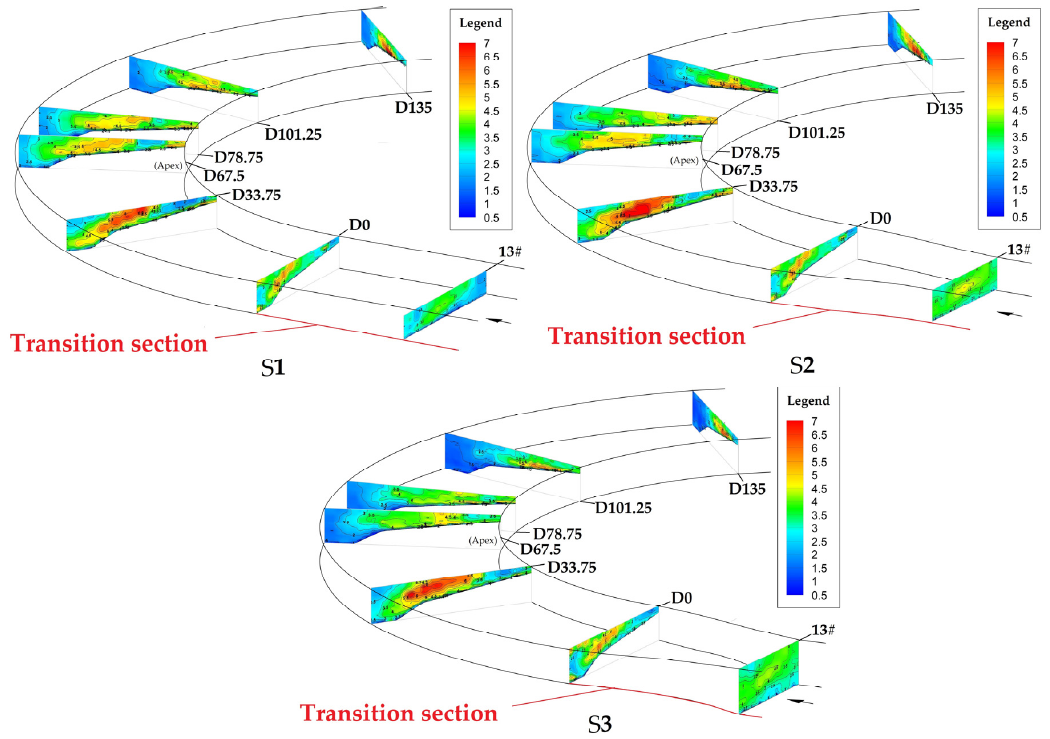
Figure 12. Distribution of the TKE along the back bend at Q3 and at different discharges (m 2 /s 2 ).